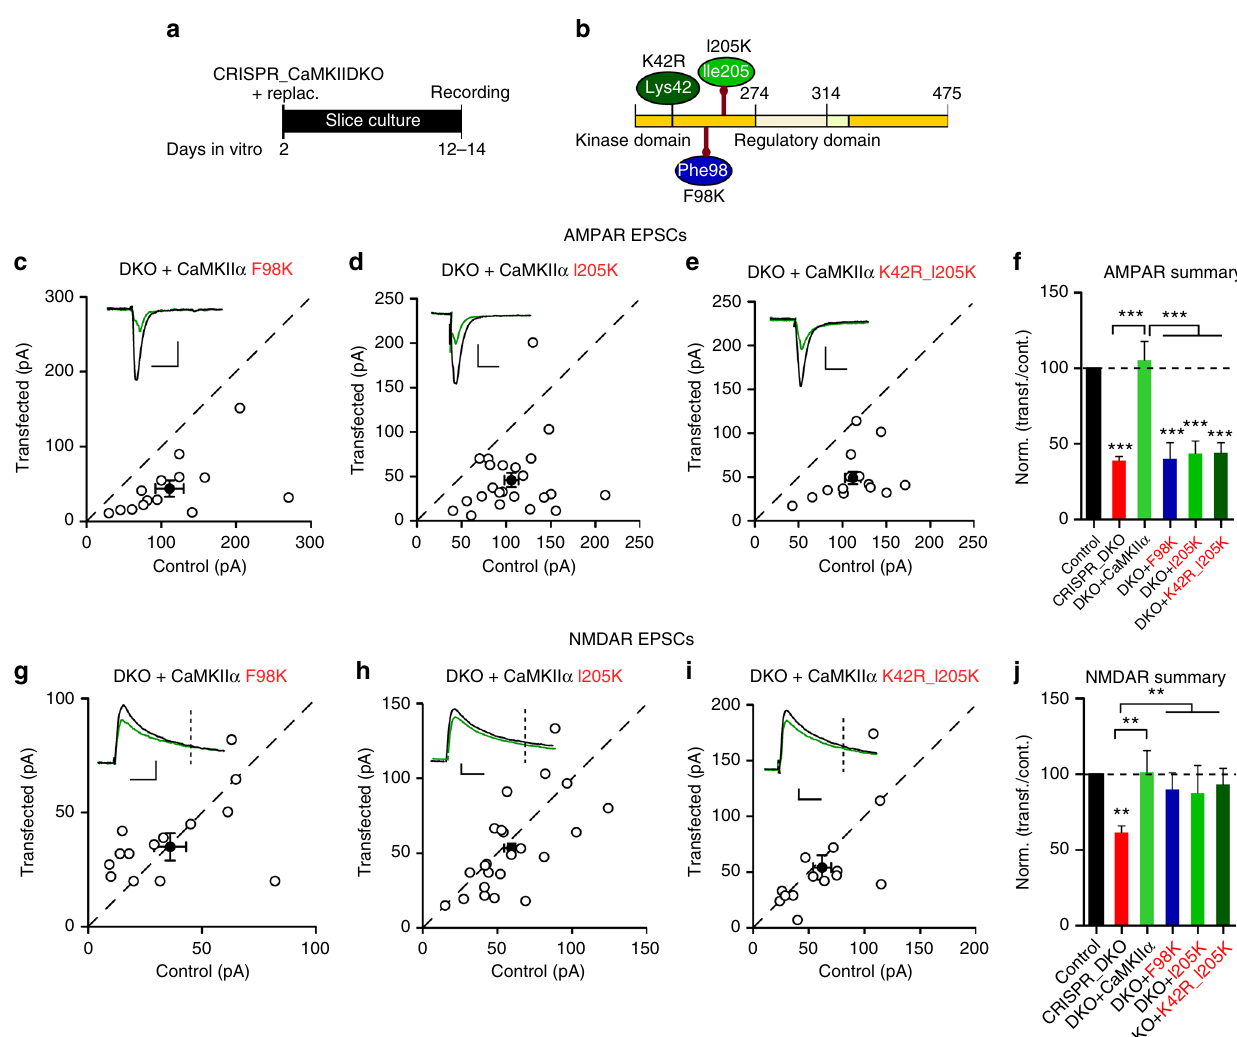
Fig. 7 CaMKII α binding to GluN2B is critical for basal AMPAR transmission. a Timeline of the experiment. b Scheme of the structural organization of CaMKII α with the point mutations indicated (K42R dark green; F98K blue; I205K light green). c − e Scatterplots showing amplitudes of AMPAR EPSCs for single pairs (open circles) of control and transfected cells of DKO + CaMKII α F98K ( c , n = 14 pairs), DKO + CaMKII α I205K ( d , n = 23 pairs), and DKO + CaMKII α K42R_I205K ( d , n = 14 pairs). Filled circles indicate mean ± SEM ( c , Control = 111 ± 19.9; DKO + CaMKII α F98K = 44.33 ± 11.8, p = 0.002; d , Control = 106.8 ± 8.1; DKO + CaMKII α I205K = 46.5 ± 8.6, p < 0.0001; e , Control = 112.5 ± 9; DKO + CaMKII α I205K_K42R = 49.5 ± 7.5, p < 0.0001). f Bar graph of ratios normalized to control (%) summarizing the mean ± SEM of AMPAR EPSCs of values represented in c (40 ± 1.1, p < 0.0001), d (45.5 ± 7.2, p < 0.0001) and e (44.6 ± 5.6, p < 0.0001). DKO data (red bar) from Fig. 1l and DKO + CaMKII α (light green) from Fig. 3e values are included in the graph. g – i Scatterplots showing amplitudes of NMDAR EPSCs for single pairs (open circles) of control and transfected cells of DKO + CaMKII α F98K ( g , n = 14 pairs), DKO + CaMKII α I205K ( h , n = 23 pairs), and DKO + K42R_I205K ( i , n = 14 pairs). Filled circles indicate mean ± SEM ( g , Control = 36.2 ± 7.7; DKO + CaMKII α F98K = 35.3 ± 6, p = 0.49; h , Control = 59.3 ± 5.4; DKO + CaMKII α I205K = 53.2 ± 6.4, p = 0.20; i , Control = 62.8 ± 8.5; DKO + CaMKII α I205K_K42R = 54.9 ± 11.4, p = 0.18) j Bar graph of ratios normalized to control (%) summarizing the mean ± SEM of NMDAR EPSCs of values represented in g (101 ± 14, p = 0.62), h (91.1 ± 7.3, p = 0.74) and i (88.2 ± 10.2, p = 0.66). DKO data (red bar) from Fig. 1p and DKO + CaMKII α (light